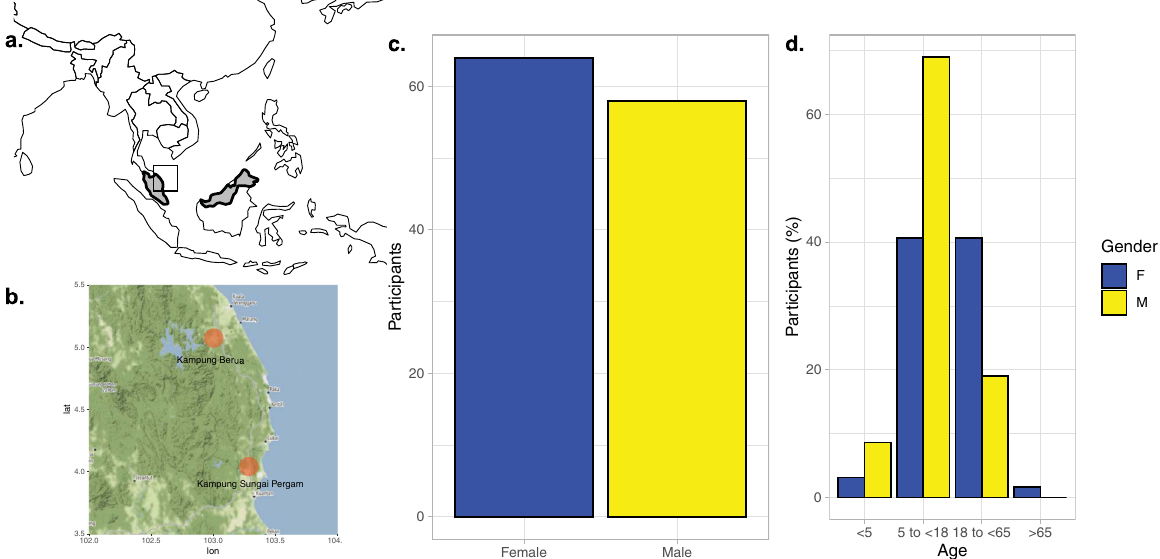
Fig. 1 Location of Orang Asli sites with age and gender demographics. The location of Orang Asli settlements were in the north-east of Peninsula Malaysia ( a ) to the south of the Terengganu state ’ s capital city, Kuala Terengganu ( b ). An even gender split was achieved ( c ) but with disproportionate recruitment in older children >5 years of age and adults less than <65 ( d population of Malaysia but are disproportionately impacted by economic marginalisation and discrimination 16 . Nearly 80% of the Orang Asli population are beneath the poverty line compared to 1.4% of the national population, and this hardship is re fl ected in a 20-year lower average life expectancy of just 53 years 17 . Several